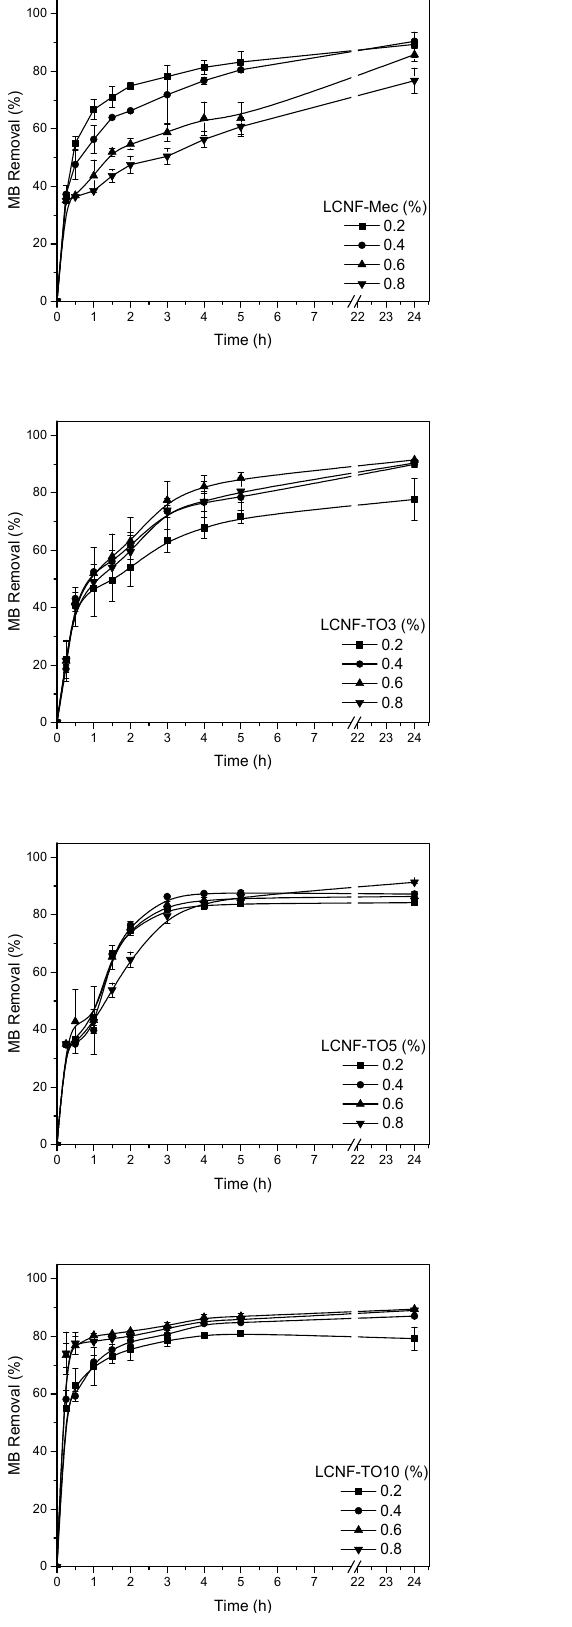
Figure 5. Methylene blue (20 mg/L) adsorption kinetics for the different aerogels. In general, two phases are observed in the adsorption curves. The first phase de- scribes an exponential dye removal due to the high availability of hydroxyl and carboxyl groups present in the aerogel (negative charge) to interact with methylene blue (positive